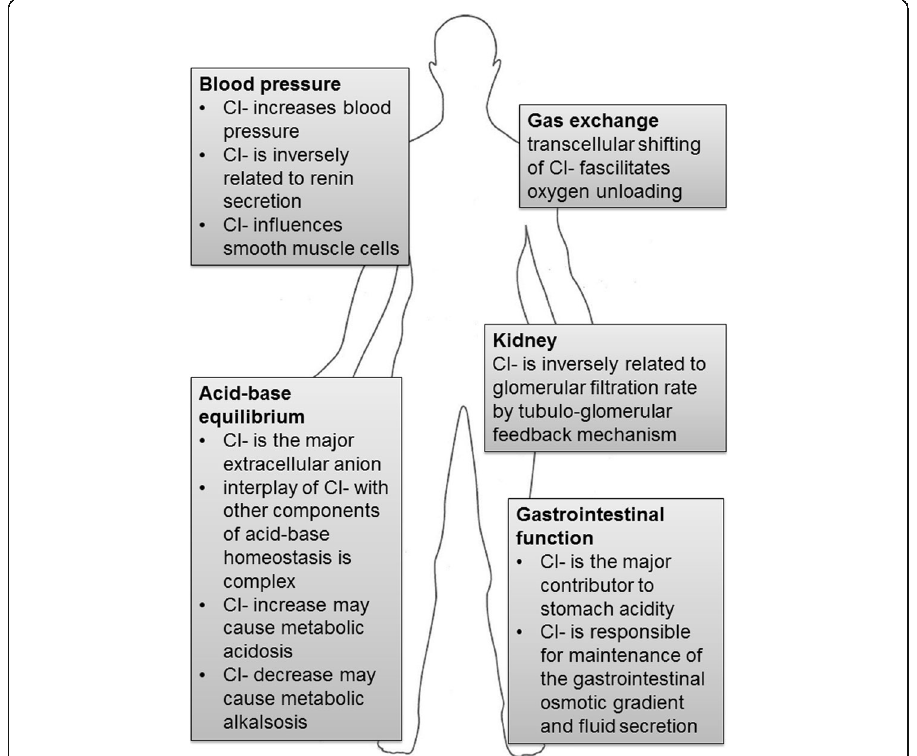
Fig. 1 The principal physiological functions of chloride in the human